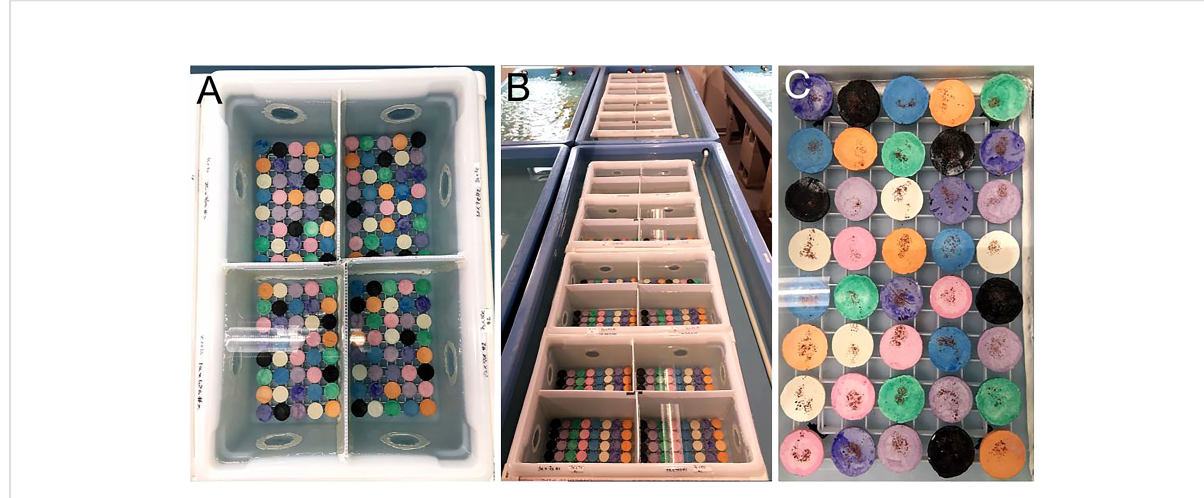
FIGURE 4 Coral larval settlement in fl ow-through containers and testing larval preferences associated with spectral cues. (A) Indigo, white, orange, black, pink, green, purple, and blue ceramic substrates (plugs) were used to test which color coral larvae were attracted to during settlement. (B) Settlement assays were conducted in fl ow-through bins held within raceways with a continuous in fl ux of fresh seawater. (C) CCA fl akes were dusted onto each plug to provide a chemical cue for settlement. Source: Hanna